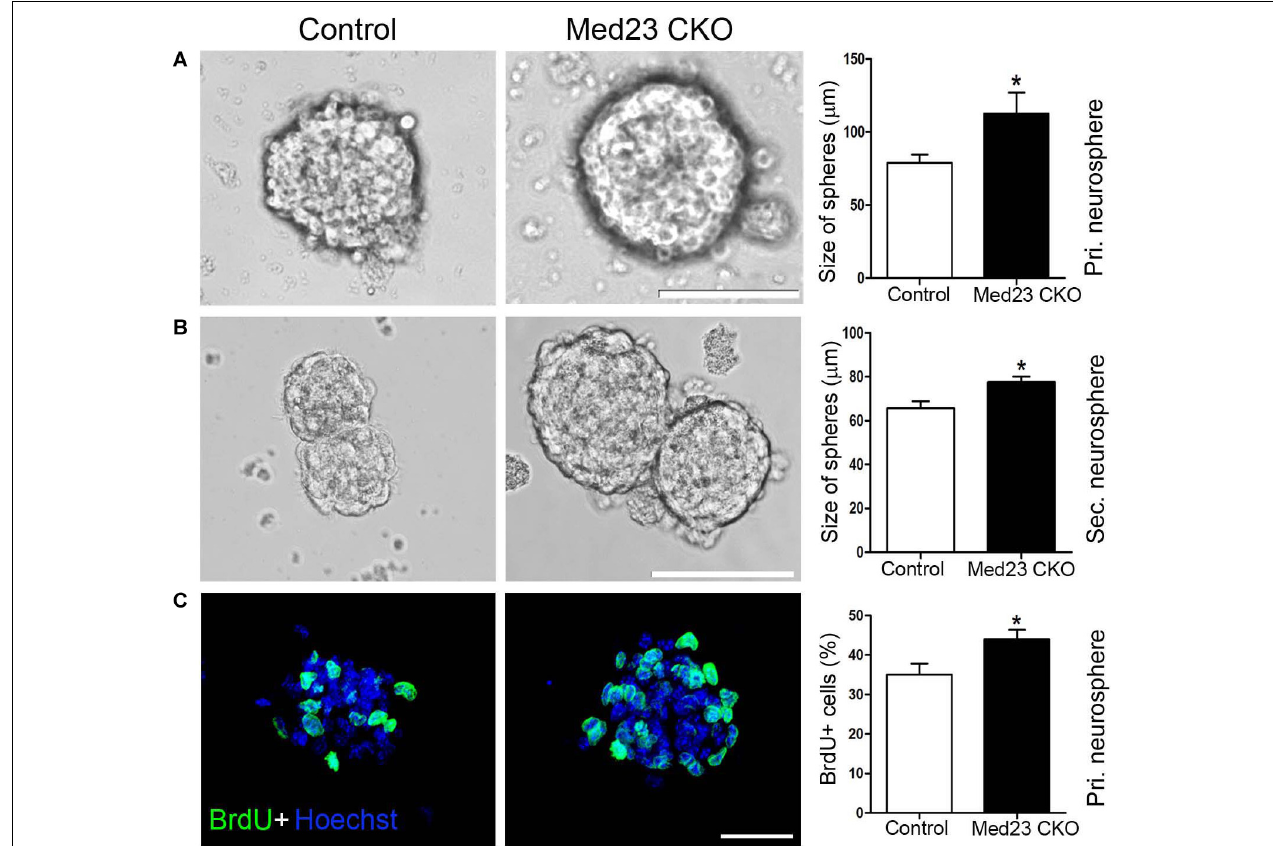
FIGURE 2 | Increased proliferation of Med23-deficient NSCs in vitro. (A,B) Primary and secondary neurospheres cultured from NSCs of control and Med23 CKO mice. About 11 primary neurospheres were obtained from each mice, and a total of eight mice were used in each group. For the analysis of secondary neurospheres, eight neurospheres were included from each mouse and eight mice were used in each group. Scale bars = 100 µ m. (C) Immunostaining of BrdU in primary neurospheres from control and Med23 CKO mice, and comparison of percentages of BrdU + cells in the total cell population. About six neurospheres were included from each mouse, and five mice were used in each group. Scale bar = 25 µ m. Data are plotted as the mean ± SEM. Student t -test, * p < 0.05.